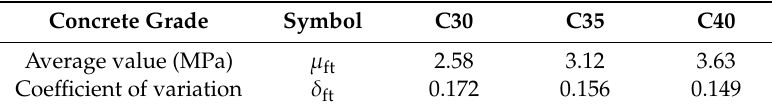
Table 5. Statistical parameters of concrete tensile strength.